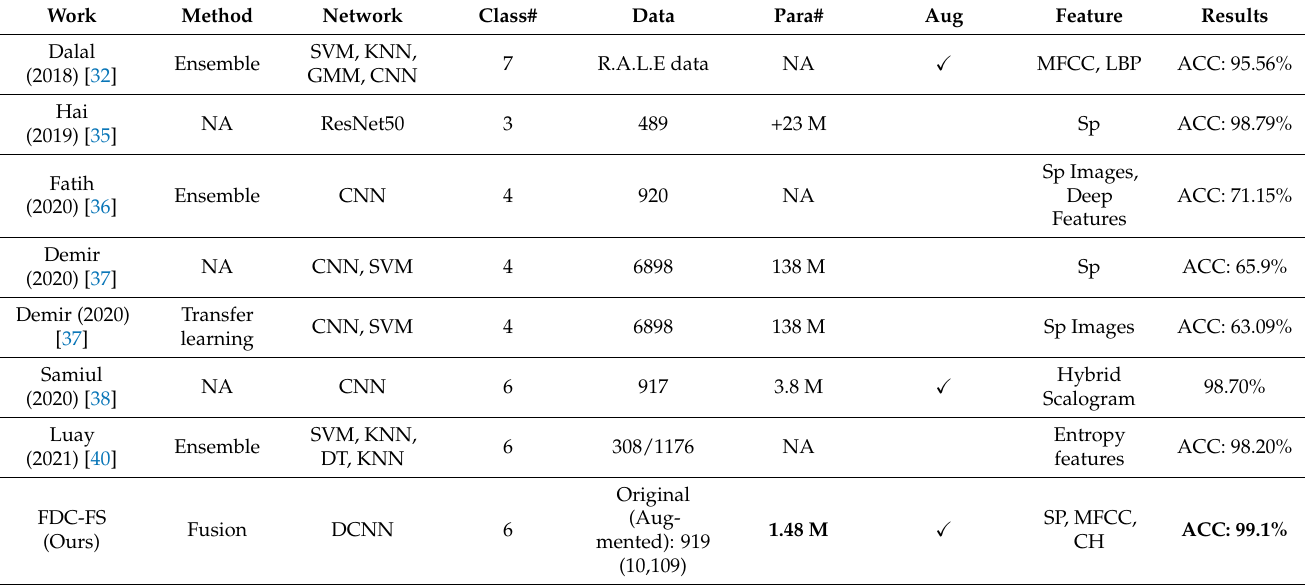
Table 12. State-of-the-art Lung Classification